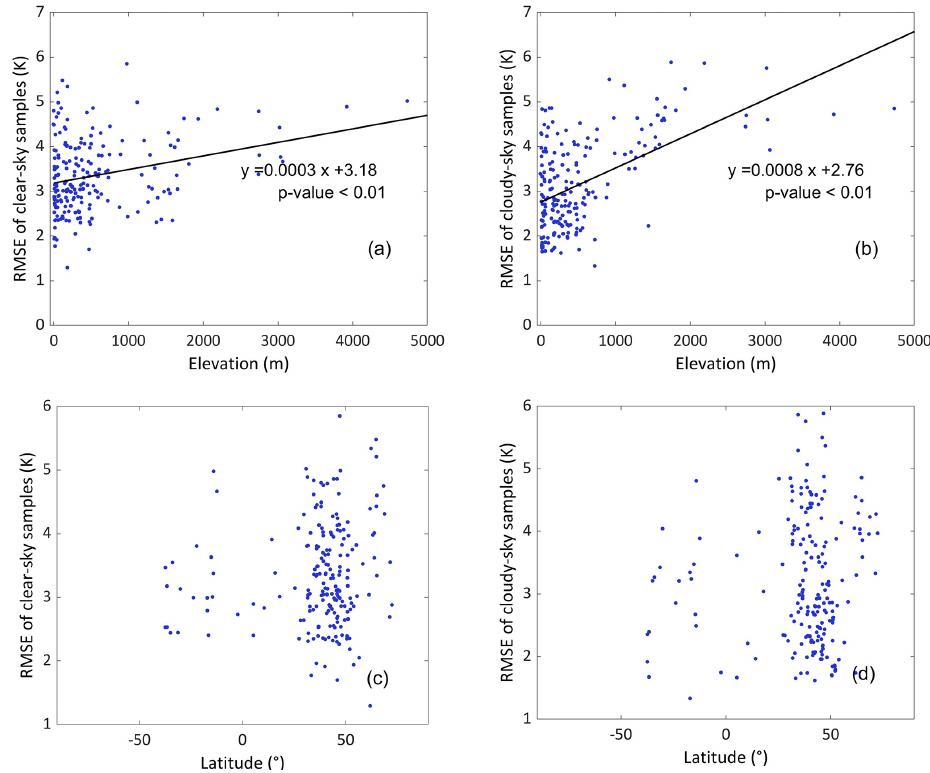
Figure 11. Scatterplots of the site RMSE against (a, b) elevation and (c, d) latitude under (a, c) clear-sky and (b, d) cloudy-sky conditions. The significant linear relationships ( p values < 0 . 01) are drawn (a, b)